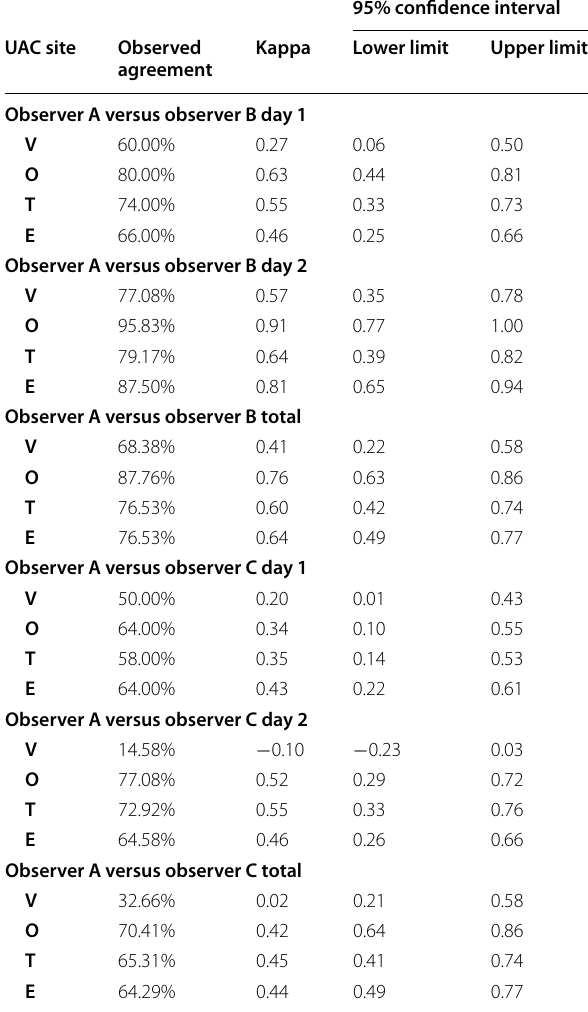
95% confidence interval